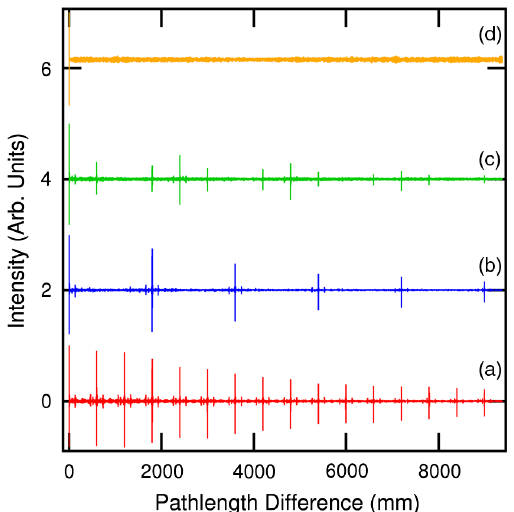
FIG. 1. Interferograms as a function of PLD for various bunch- train fill patterns. The large peaks arise from the correlations between bunches separated along the train by a distance equal to the PLD. (a) Fill pattern 111111 . . . ; (b) fill pattern 100100 . . . ; (c) fill pattern 11001100 . . . ; (d) same as (a) but with incoherent synchrotron radiation [(b), (c), and (d) offset for clarity].